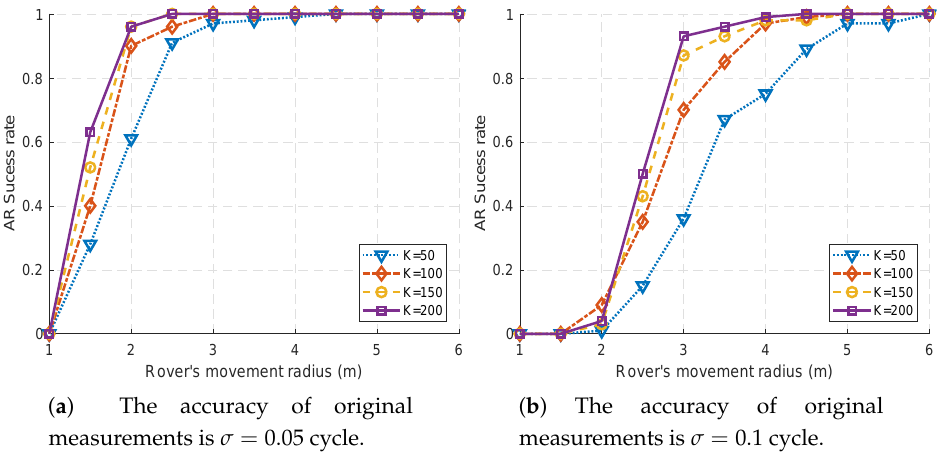
Figure 2. The comparison of AR success rates. The rover’s movement radius is increased from 1 m to 6